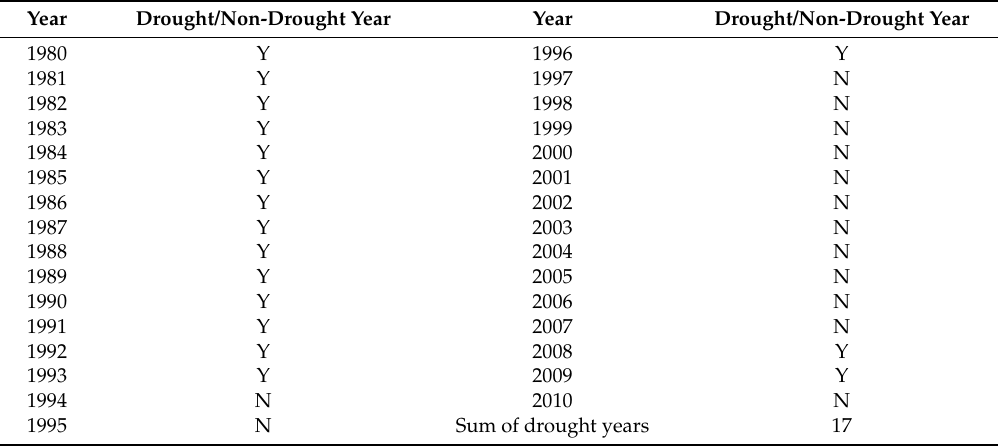
Table 2. The drought conditions for each year.